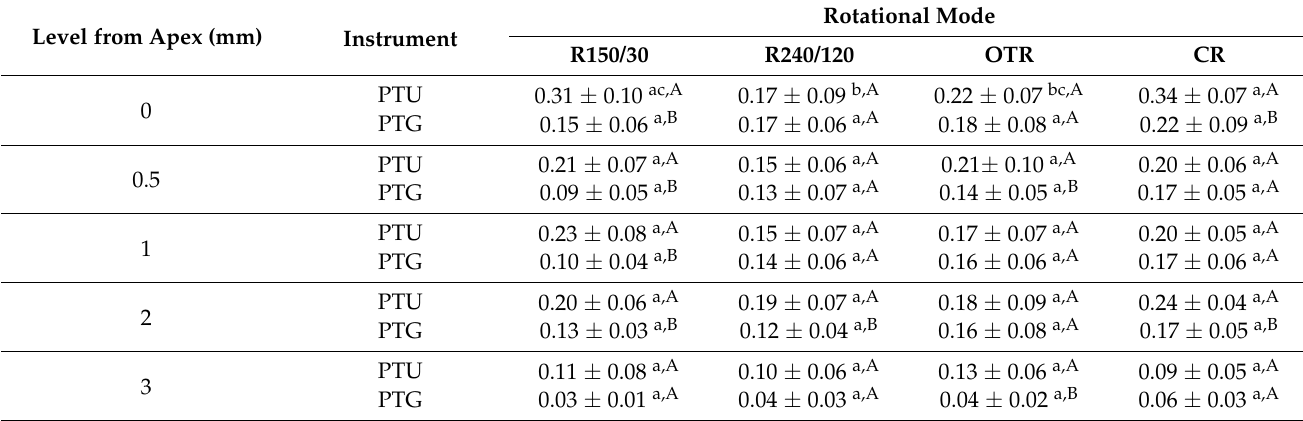
Table 1. Canal centering